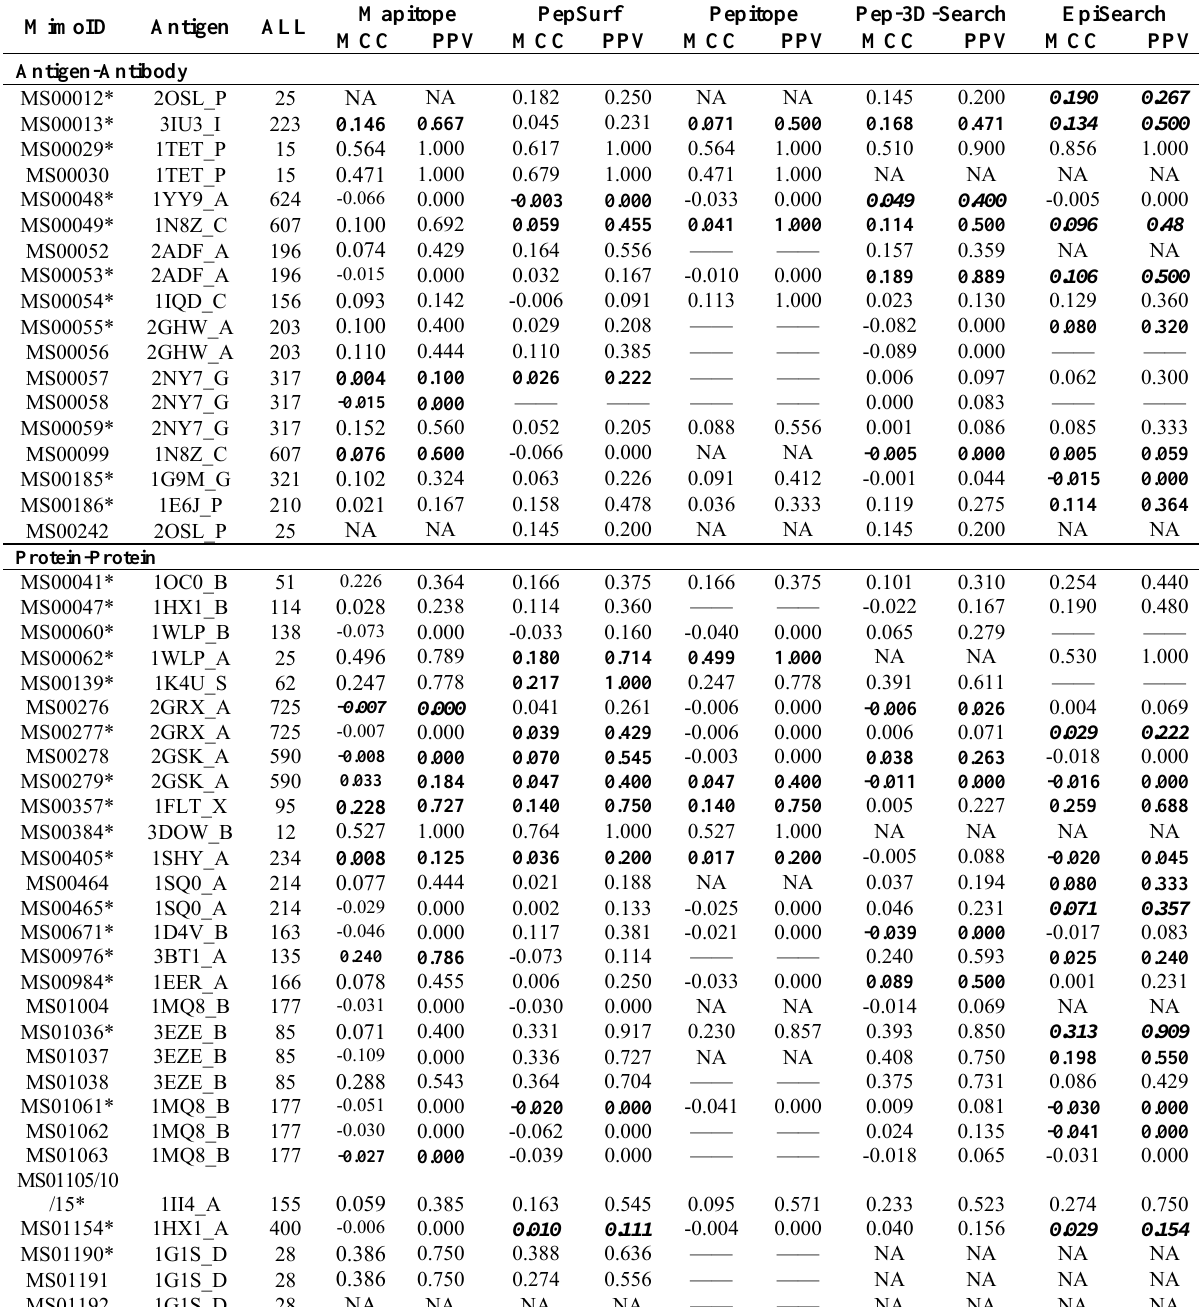
Table 2. MCC and PPV of each method on the benchmark datasets. The data which belong to the representative dataset were marked with *. (1) ‘NA’ means that the results for epitopes were not obtained; (2) ‘—’ means that the data has restriction of the sequence length or the sequence number; (3) The best resulting cluster that was found in the second- ranked cluster is shown in bold; (4) The best resulting cluster that was found in the third- ranked cluster is shown in italic; (5) “ALL” means the residue number of the